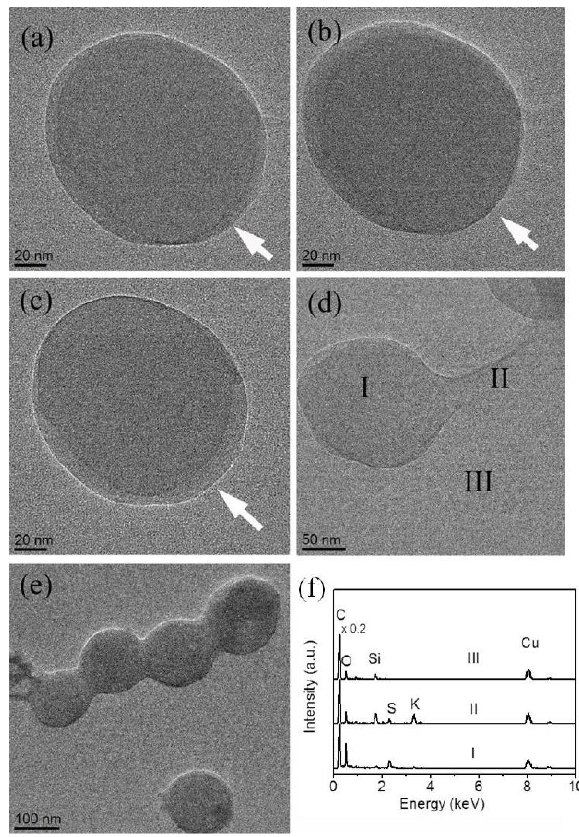
Figure 8. TEM images of an amorphous carbon sphere (brown carbon) collected at 1500 m, with TEM stage tilted at (a) 0, (b) 10, and (c) − 10 ◦ . (d) A brown carbon sphere with a tail. (e) Four brown carbon spheres connected together in a line. (f) EDS from three areas inside image (d) . The intensity of carbon peak is multiplied by factor of 0.2 for comparison with the weak signals from other